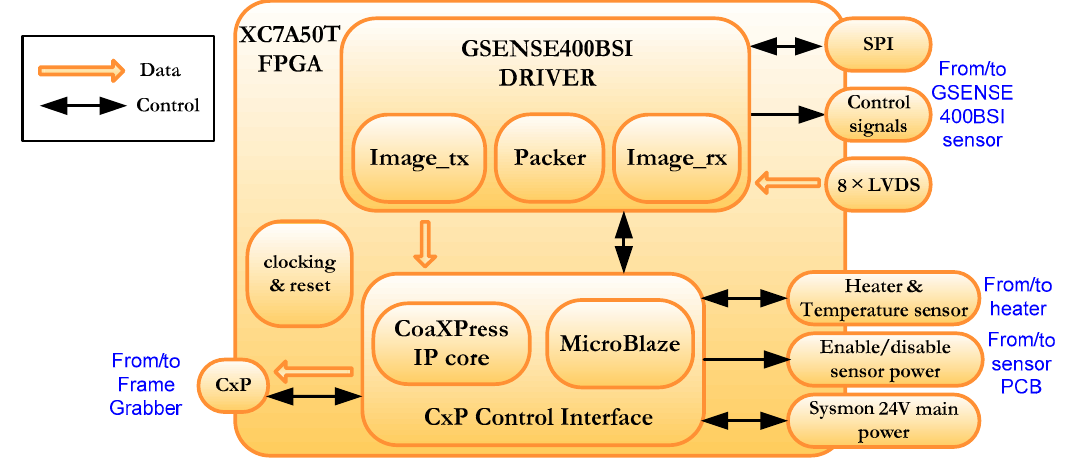
Figure 3. Camera FW device architecture.